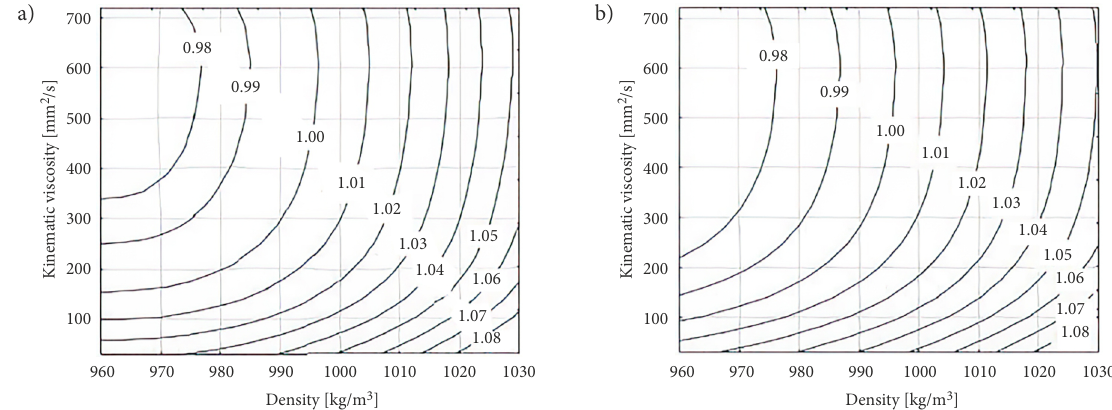
Figure 8. Multivariate characteristics of relative BSFC change in MAN B&W 6S60MC engine: